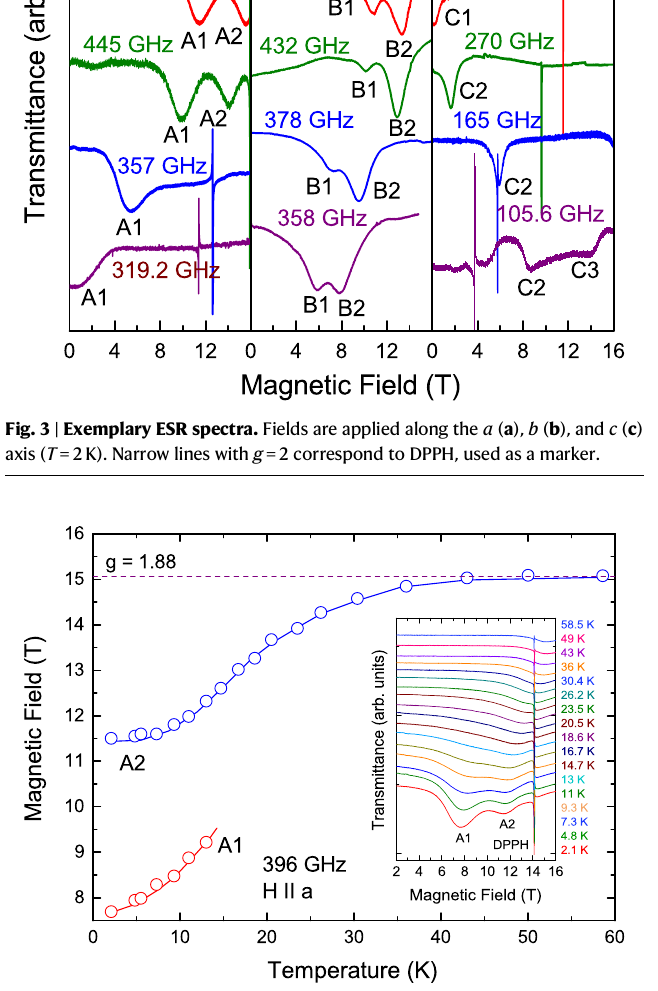
Fig. 4 | Temperature dependences ofESR fi elds inCROC. The data are taken ata frequency of 396 GHzwith magnetic fi eldapplied alongthe a axis.The dashedline corresponds to the paramagnetic g =1.88. The solids lines are guides for the eye. Theinsetshowscorrespondingspectraatdifferenttemperatures(narrowlineswith g =2 correspond to DPPH, used as a